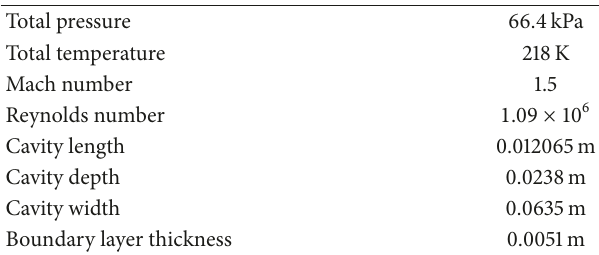
Table 1: Numerical